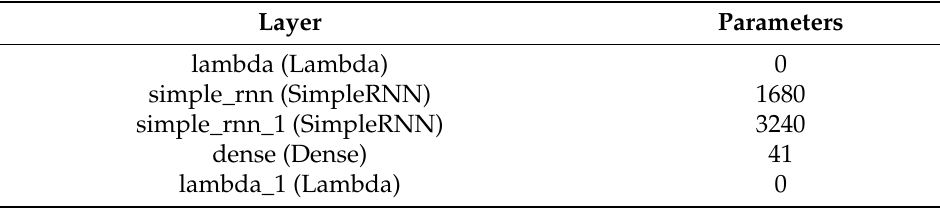
Table 2. Parameter breakdown per model—RNN.